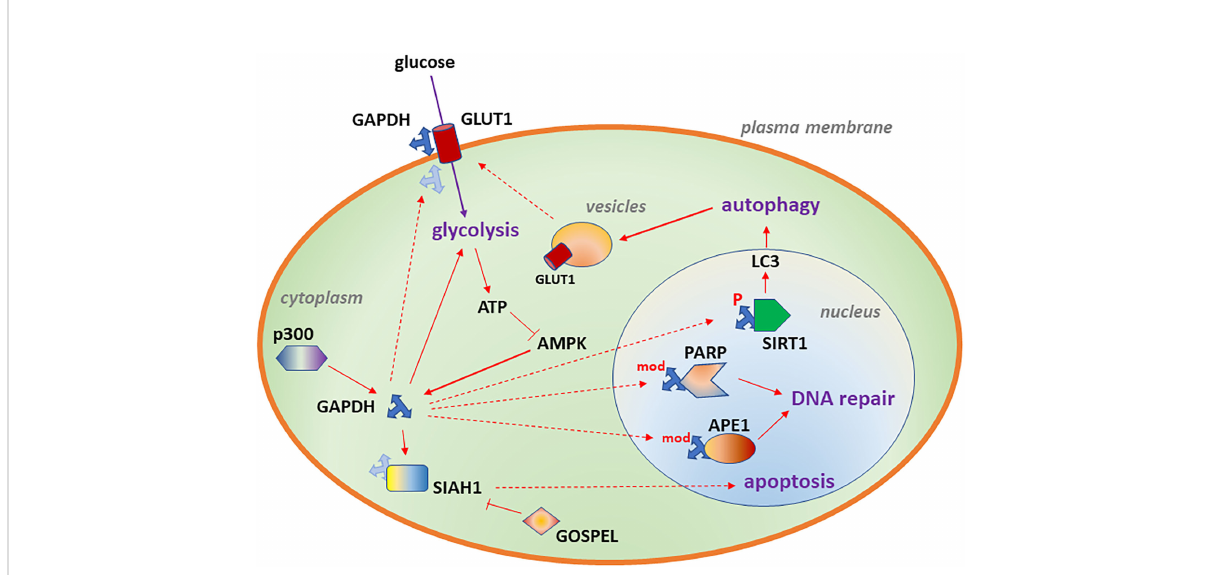
FIGURE 1 Diagram depicting subcellular localizations of GAPDH associated with glycolysis (cytoplasm), DNA repair (nucleus), autophagy (nucleus) and increased glucose transport (plasma membrane). Likely binding partners are also shown. Details of the model are described in Aim